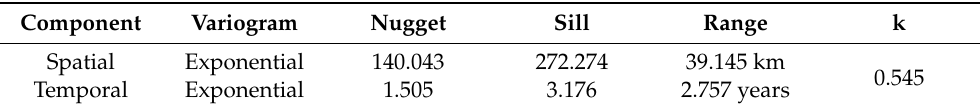
Table 3. Estimates of the generalized product-sum theoretical model adjusted to the number of days without rain per year in the State of Para í